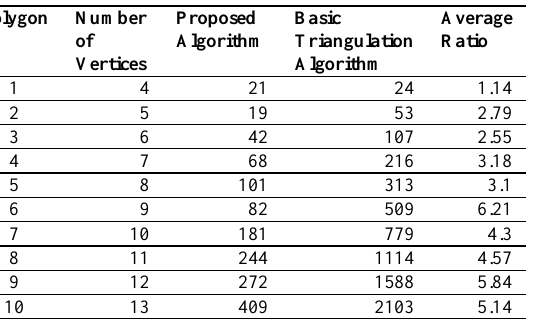
Table 2: Number of clock cycles comparison Table 3: Number of clock cycles